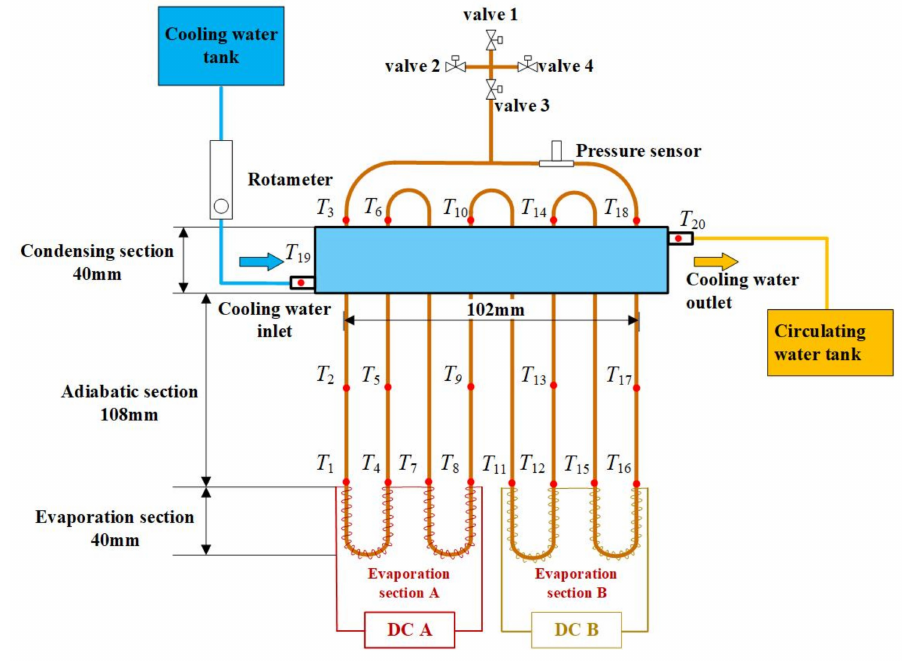
Figure 2. Schematic diagram of pulsating heat pipe experimental device with non-uniform heating. Data measurement includes temperature measurement and pressure